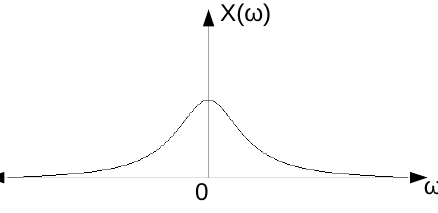
Figure 13. Double exponential pulse in the frequency domain.